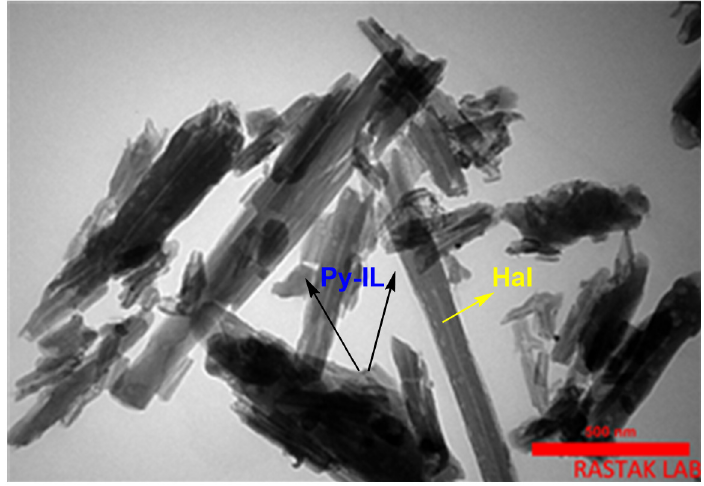
Figure 3 . TEM image of Hal-Py-IL. Figure 3. TEM image of